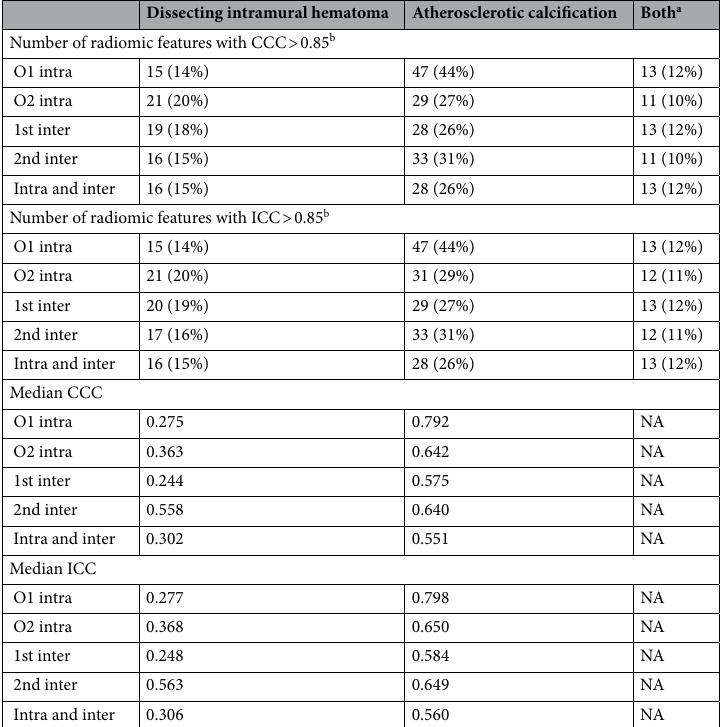
Table 3. Intra- and interobserver reproducibility of radiomic features from QSM in dissecting intramural hematomas and atherosclerotic calcifications. CCC concordance correlation coefficient, ICC intraclass correlation coefficient, O1 observer 1, O2 observer 2, intra intraobserver reproducibility, inter interobserver reproducibility, 1st inter interobserver reproducibility between the first measurements of observer 1 and 2, 2nd inter interobserver reproducibility between the second measurements of observer 1 and 2, Intra and inter reproducibility across the first and second measurements of both observer 1 and 2. a Number of radiomic features with CCC or ICC > 0.85 in both dissecting intramural hematomas and atherosclerotic calcifications was counted. b Data indicate numbers of reproducible radiomic features and parentheses indicate their